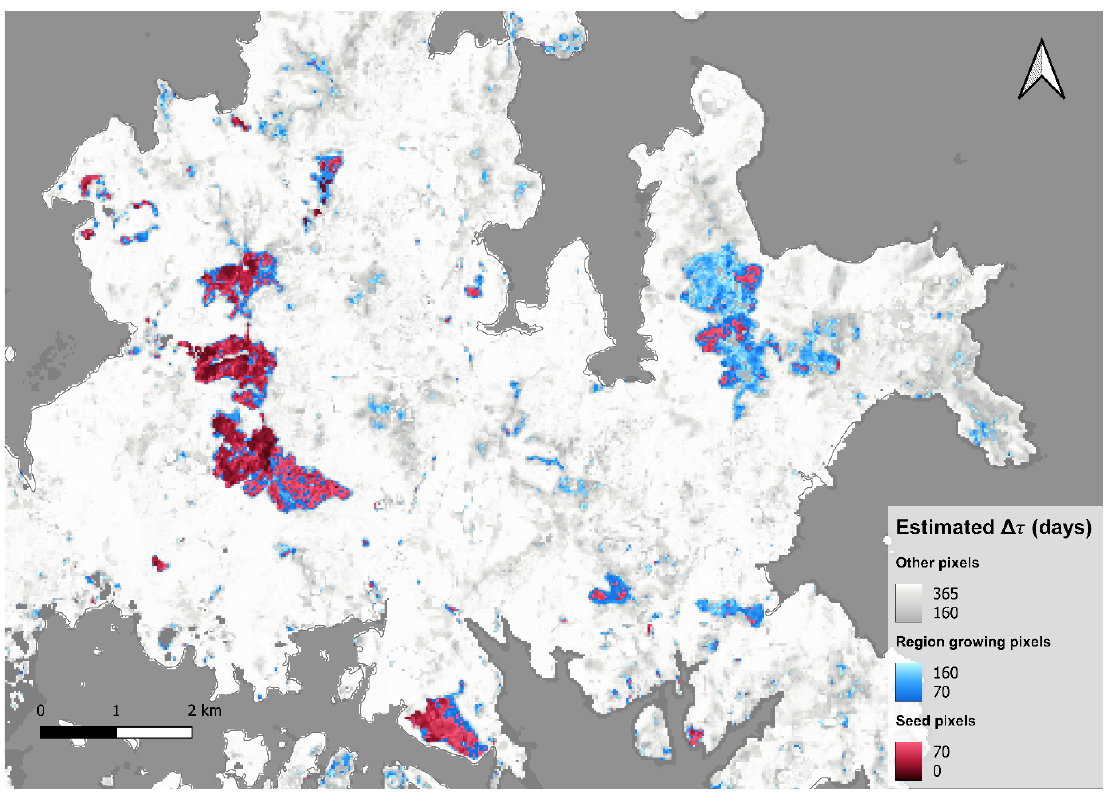
Figure 4. Raster showing estimated Δ 𝜏 of Sai Kung Peninsula, Hong Kong (22°2 5′ 14.4 ″ N, 114°1 9′ 51.4 ″ E) for the summer of 1996. We trained a Random Forest model that estimated Δ 𝜏 from bands in the seasonal min-NBR composites. Δ 𝜏 is a proxy for burn area resemblance. A lower Δ 𝜏 indicates closer resemblance to burn-area pixels, while a higher ∆ τ indicates closer resemblance to unburn pixels. Red and blue areas indicate the seed and growth pixels after